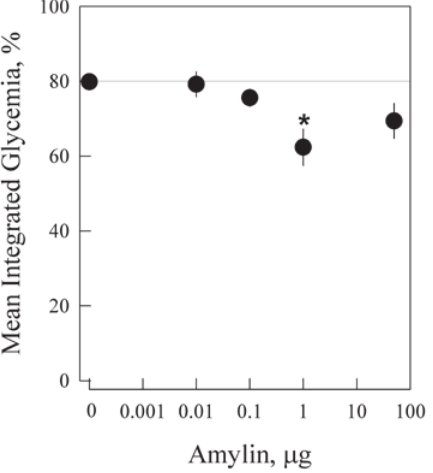
Figure 3 - Amylin dose-response for the decrease in whole blood glycemia. Mouse amylin was administered via subcutaneous injection in 4 h-fasted mice (n = 4 per group). Their glycemia was monitored from whole blood collected from the tail tip. The glycemia for each mouse ( Fig. 1 ) was integrated over time for 1-6 h after administration of the mouse amylin and the plotted points represents the mean ± s.e.m. as a function of the respective amylin dose.. * p < 0.02 (unpaired t-test). Further details can be found in the Methods